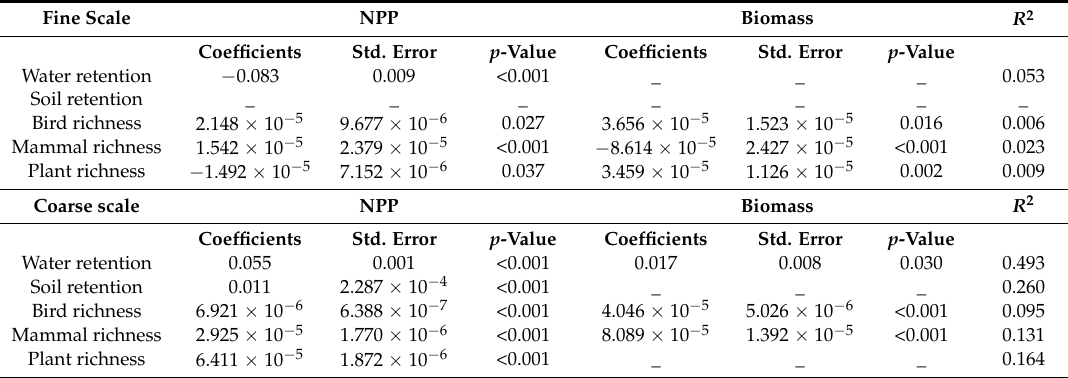
Table 2. Impacts of NPP and biomass on biodiversity and regulating ecosystem services.